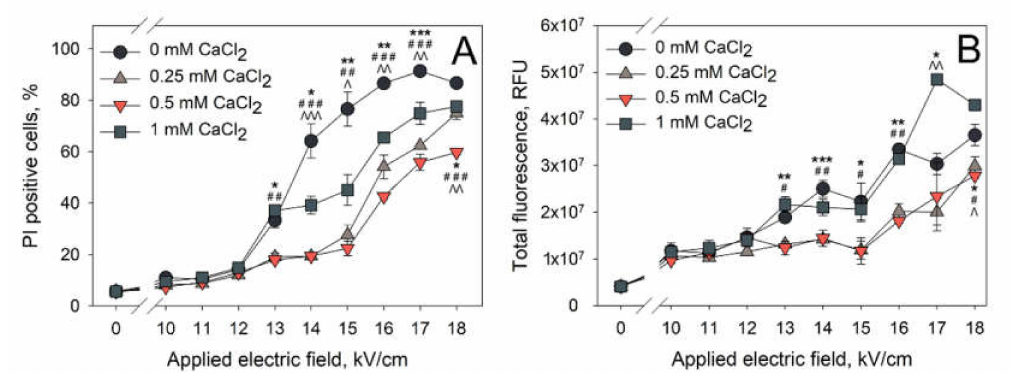
Figure 3. Dependence of PI electrotransfer e ffi ciency ( A ) and total cell fluorescence ( B ) of the treated cells on the applied electric field strength at various CaCl 2 concentrations. Cells were treated using 10 square HV pulses at a 200-ns pulse duration. PI fluorescence was measured 15 min after electric field application. The statistical di ff erences between PI uptake (PI positive cells and total fluorescence) between control (0 mM CaCl 2 concentration) and 0.25, 0.5, 1 mM CaCl 2 concentrations are denoted by *, # and ˆ, respectively. One symbol denotes p < 0.05, two symbols— p < 0.01, three symbols— p < 0.001. The error bars represent the mean ± standard error of mean of n = 6 experimental